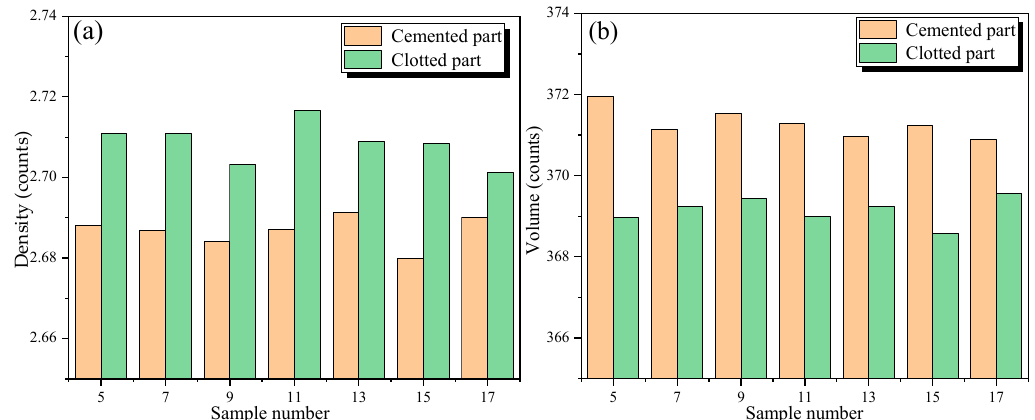
Figure 3. ( a ) The results of the changes in cell density of cemented and clotted parts; ( b ) the results of the changes in cell volume of cemented and clotted parts.